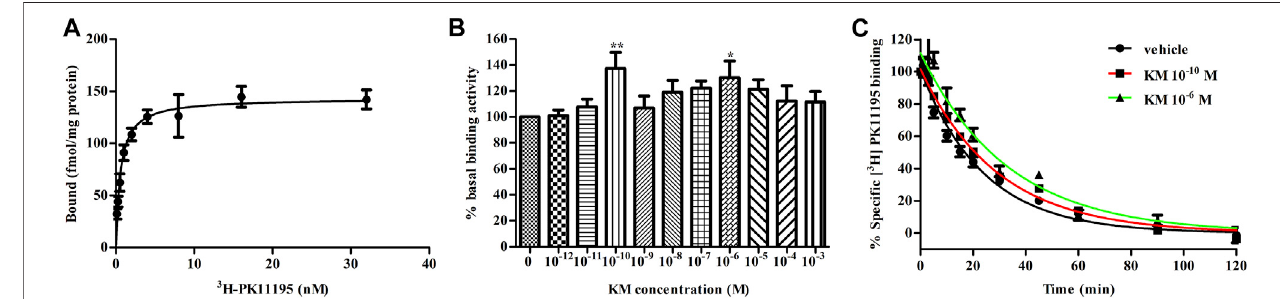
FIGURE 2 | Koumine delays the dissociation of 3 H-PK11195 from TSPO. (A) Saturation binding curve of speci fi c 3 H-PK11195 binding. (B) Binding activity of 0.1 nM 3 H-PK11195 in the absence or presence of different concentrations of koumine. (C) The dissociation curves of 3 H-PK11195 in the absence or presence of the indicated concentrations of koumine. For (A) and (B) , 50 μ g of TSPO protein was incubated for 120 min at 4 ° C with 0.125 – 32 nM 3 H-PK11195 (A) or 0.1 nM PK11195 intheabsenceorpresenceofdifferentconcentrationsofkoumine (B) .Speci fi cbindingisde fi nedasthedifferencebetweentotalbindingandnonspeci fi cbindingin the presence of 1000-fold excess unlabeled PK11195. In (B) , the basal binding activity was the speci fi c binding value (cpm) in the absence of koumine and was de fi ned as 100%. For (C) , 50 μ g of TSPO protein was incubated for 120 min at 4 ° C with 10 nM 3 H-PK11195 to achieve pre-equilibration, and dissociation was induced by 10 μ M PK11195 in the absence or presence of the indicated concentrations of koumine. Speci fi c binding is de fi ned as the difference between total binding and nonspeci fi c binding in the presence of 10 μ M PK11195. Abbreviations: KM, koumine. Data are represented as the mean ± SEM of 4 – 5 independent experiments performed in duplicate ( n (cid:2) 4 – 5). * p < 0.05, ** p < 0.01 vs. vehicle group. Statistical analysis in (B) was performed using one-way ANOVA followed by the LSD post hoc